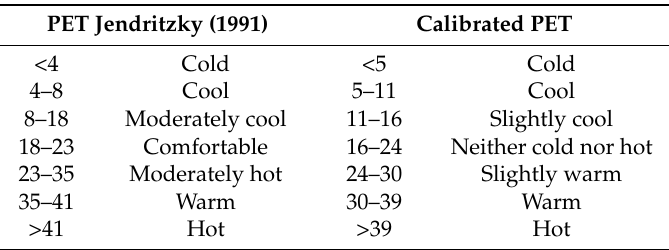
Table 4. Cutoff points for classes corresponding to the variable Response to Question 1 (*) of the questionnaire, calibrated for the